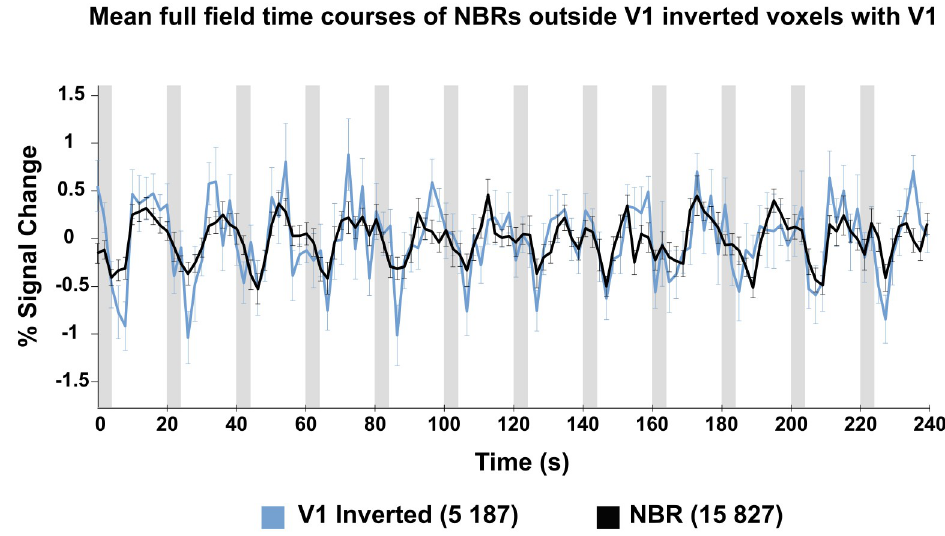
Fig 12. Average full field time course from inverted V1 voxels and NBRs, averaged across the left and right hemispheres of all subjects. The time course of inverted voxels is noisier and shows stronger variability and percent signal change compared to the NBR time course. Error bars represent +-1 SEM. Grey blocks indicate stimulus ON periods.